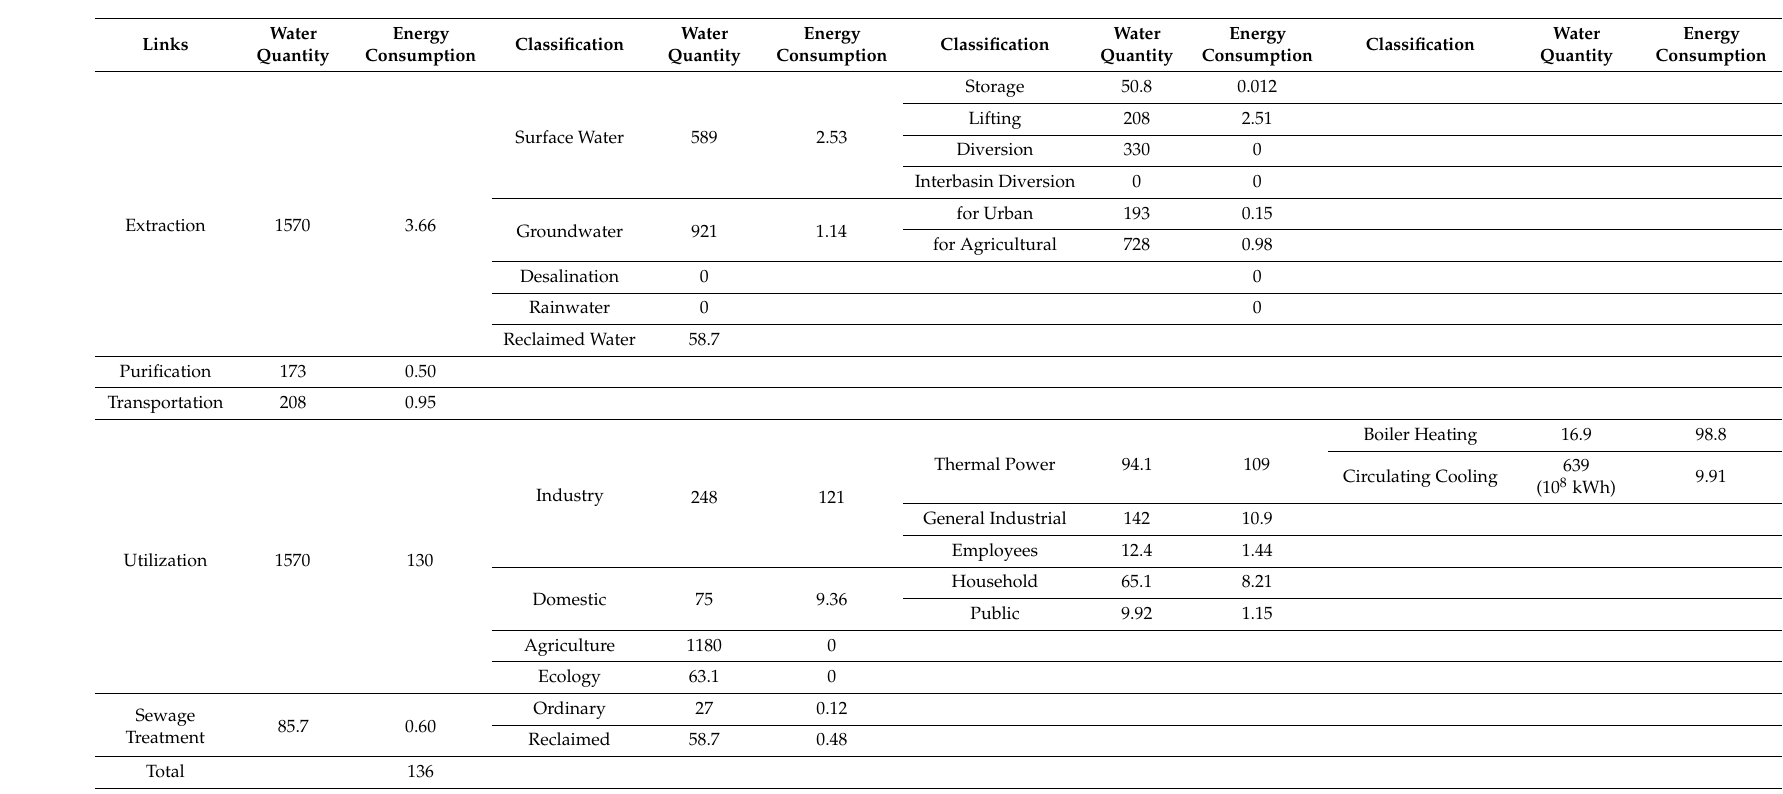
Table A3. Energy consumed through the use of water in Ordos, China, for